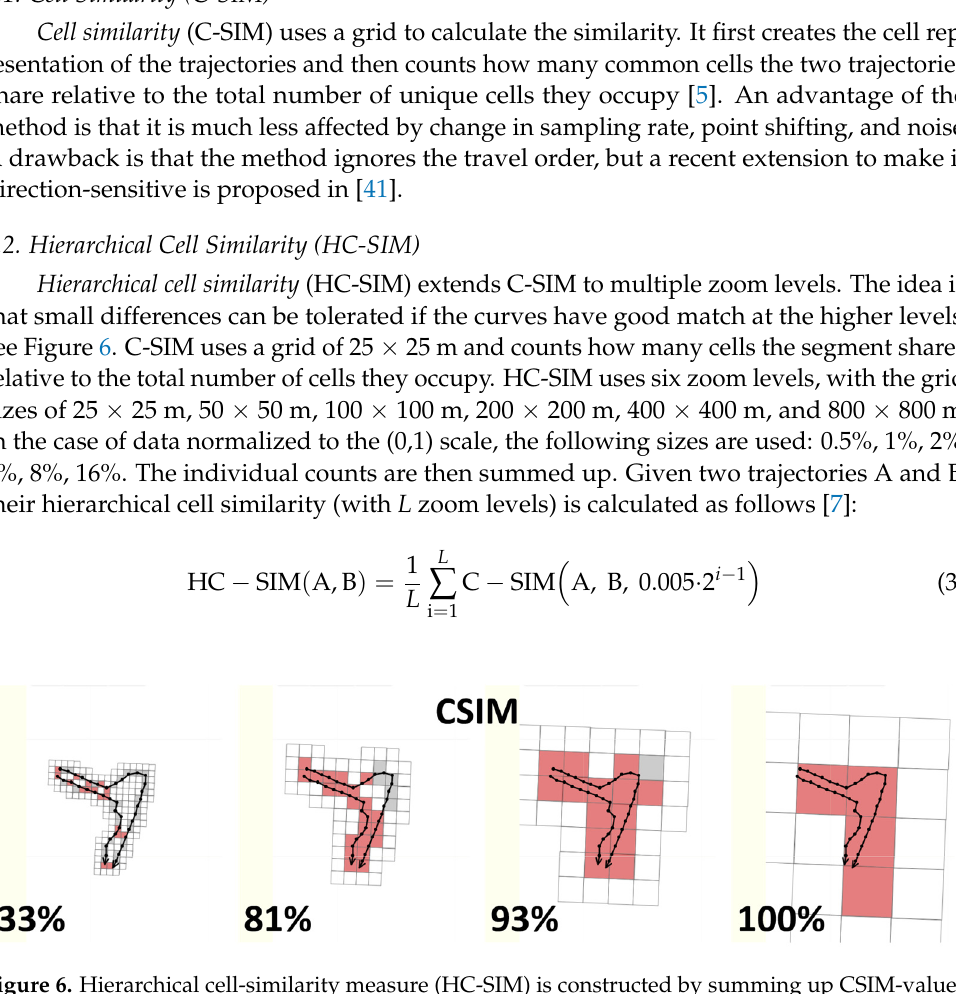
Figure 6. Hierarchical cell-similarity measure (HC-SIM) is constructed by summing up CSIM-values using different zoom levels. In the example, the two trajectories have only one short detour and minor differences showing only at the densest zoom level. At the highest zoom level, the curves are considered identical.